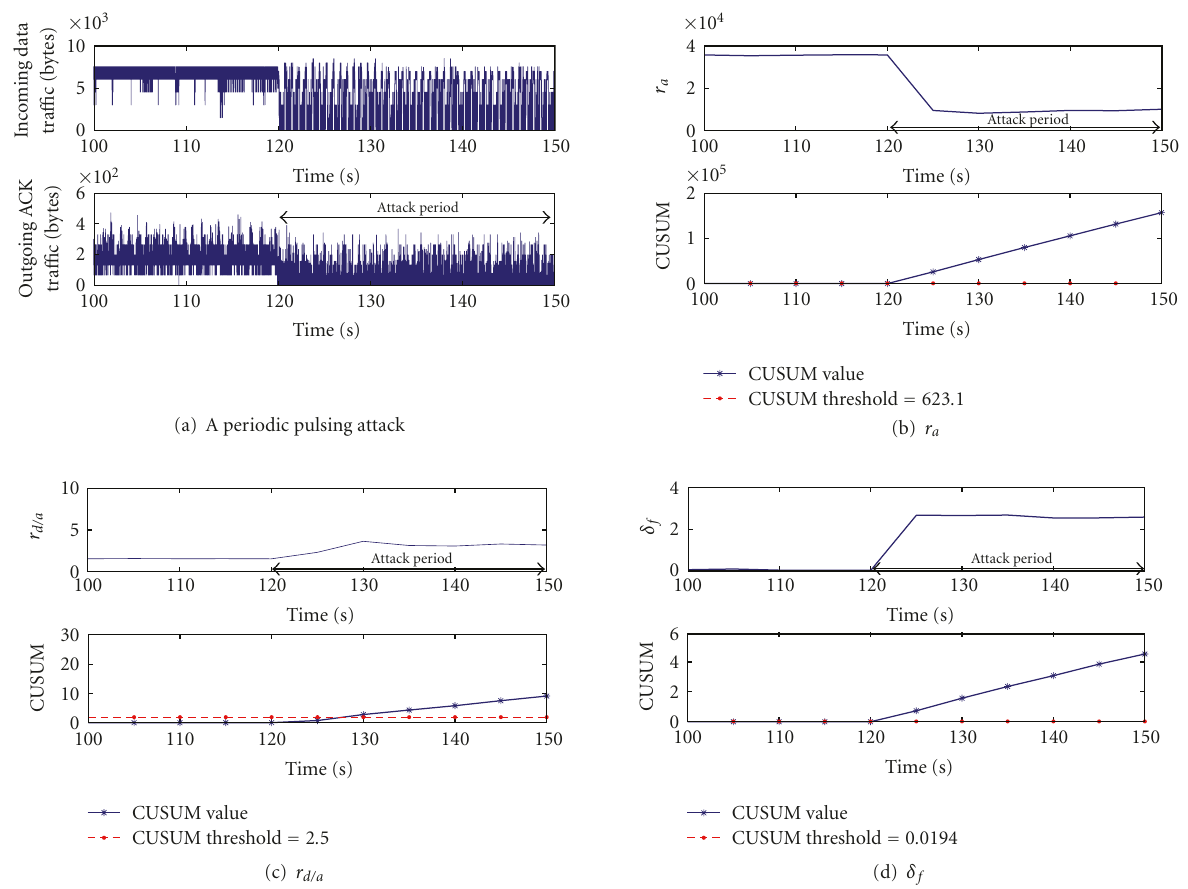
Figure 4: Detecting periodic pulsing attacks using